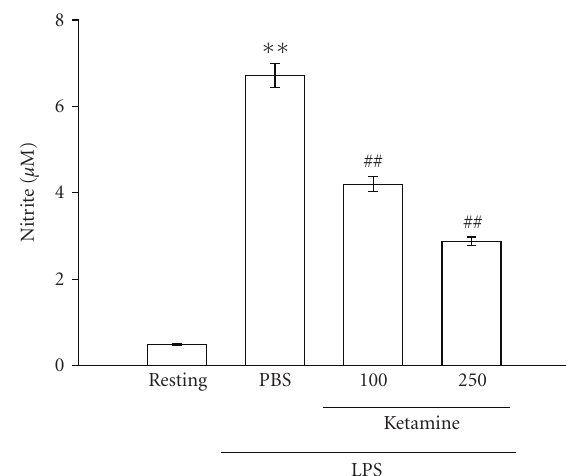
Figure 1: E ff ect of ketamine on nitrite formation in LPS-activated microglia. Microglia (5 × 10 5 cells mL − 1 ) were treated with ketamine (100 and 250 μ M) or an isovolumetric PBS bu ff er for 30 minutes, followed by the addition of LPS (100ng mL − 1 ) for 24 hours. Cell- free supernatants were assayed for nitrite production as described in Section 2. Data are presented as the means ± S.E.M. ( n = 3). ∗∗ P < . 01, compared to the resting group; ## P < . 01, compared to the PBS-treated group.